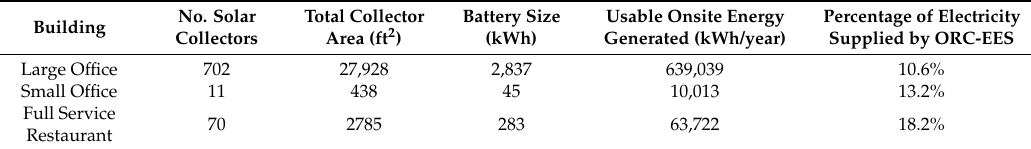
Table 3. Number of solar collectors, battery size, amount of usable onsite energy generated in one year, and percentage of yearly electricity supplied by the ORC-EES for each of the evaluated